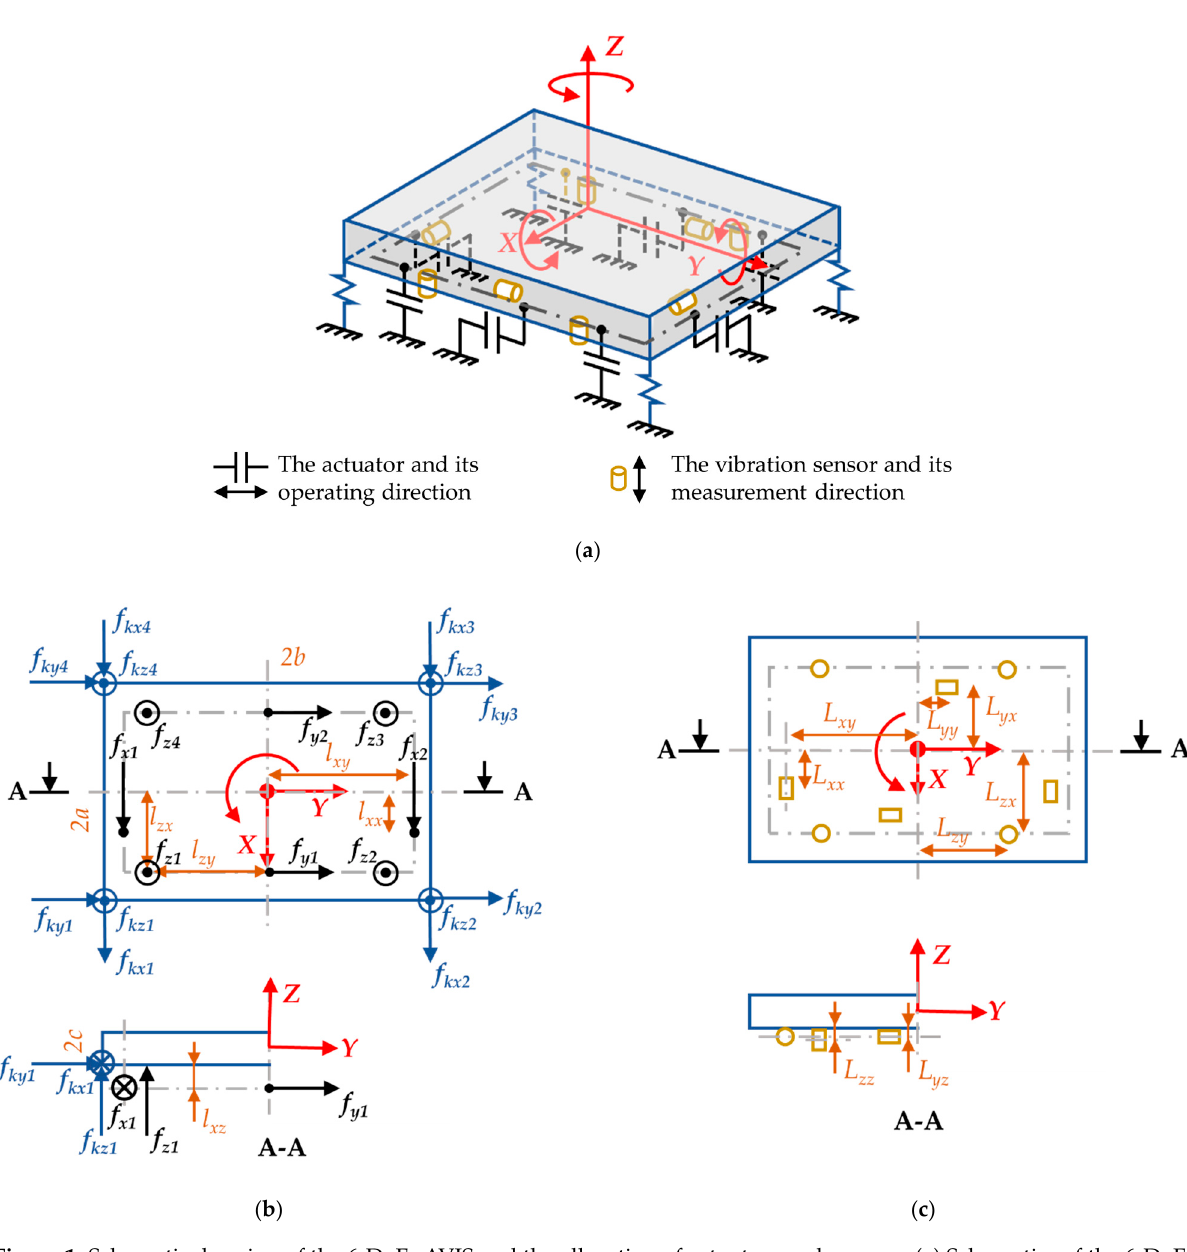
Figure 1. Schematic drawing of the 6-DoFs AVIS and the allocation of actuators and sensors. ( a ) Schematics of the 6-DoFs AVIS; ( b ) The AVIS’s orthogonal projection and allocation of spring forces and actuator’s forces; ( c ) The AVIS’s orthogonal projection and allocation of the vibration sensors.